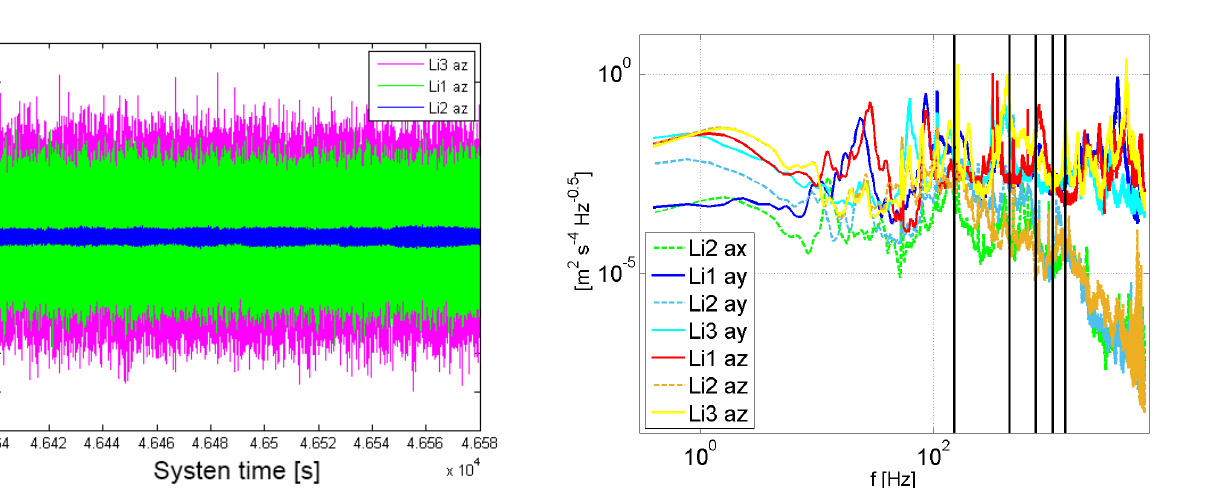
Figure 7. Acceleration spectra measured at the three humidity sen- sors Li1, Li2 and Li3 during the Do128 flight on 23 October 2015 for the same flight section as in Fig. 6. Blue and red indicate the ac- celerations of Li1 ( y and z respectively), cyan and yellow indicate the accelerations of Li3 ( y and z respectively), and the dashed lines in green, bright blue and ocher indicate the accelerations of Li2 ( x , y and z ). The vertical black bars indicate the critical frequencies of 150Hz and odd harmonics 450Hz, 750Hz, 1050Hz and 1350Hz according to the manufacturer. The data were obtained during the part of the flight indicated in yellow in Fig.